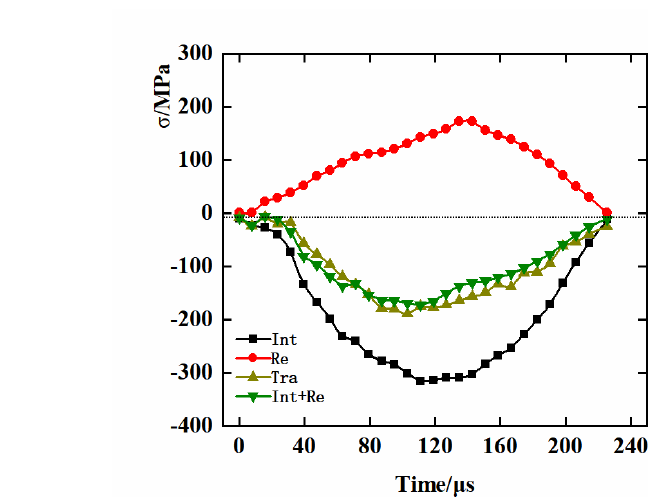
Figure 3. Stress paths and stress−time curves for the samples.